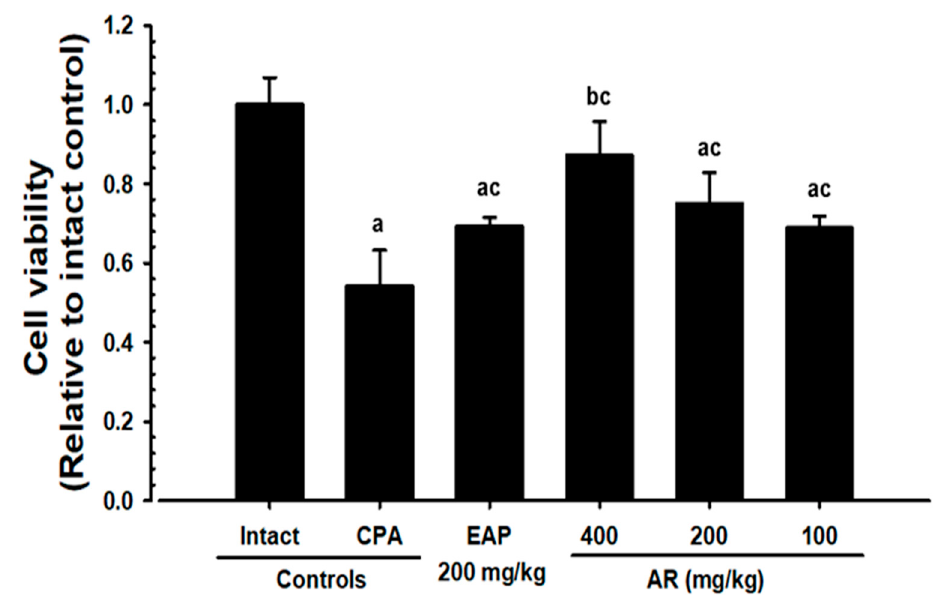
Figure 3. Effects on the ConA-induced splenocytes’ proliferation. Values are expressed as means ± S.D. of ten mice; CPA = cyclophosphamide; EAP = exopolymers purified from A. pullulans ; AR = Astragali Radix (Roots of A. membranaceus Bunge) extracts; ConA = Concanavalin A; DT3 = Dunnett’s T3; Cells were treated with 5 µg/mL of ConA dissolved in media and incubated for 48 h; a p < 0.01 and b p < 0.05 as compared with intact control by the DT3 test; c p < 0.01 as compared with CPA control by the DT3 test.